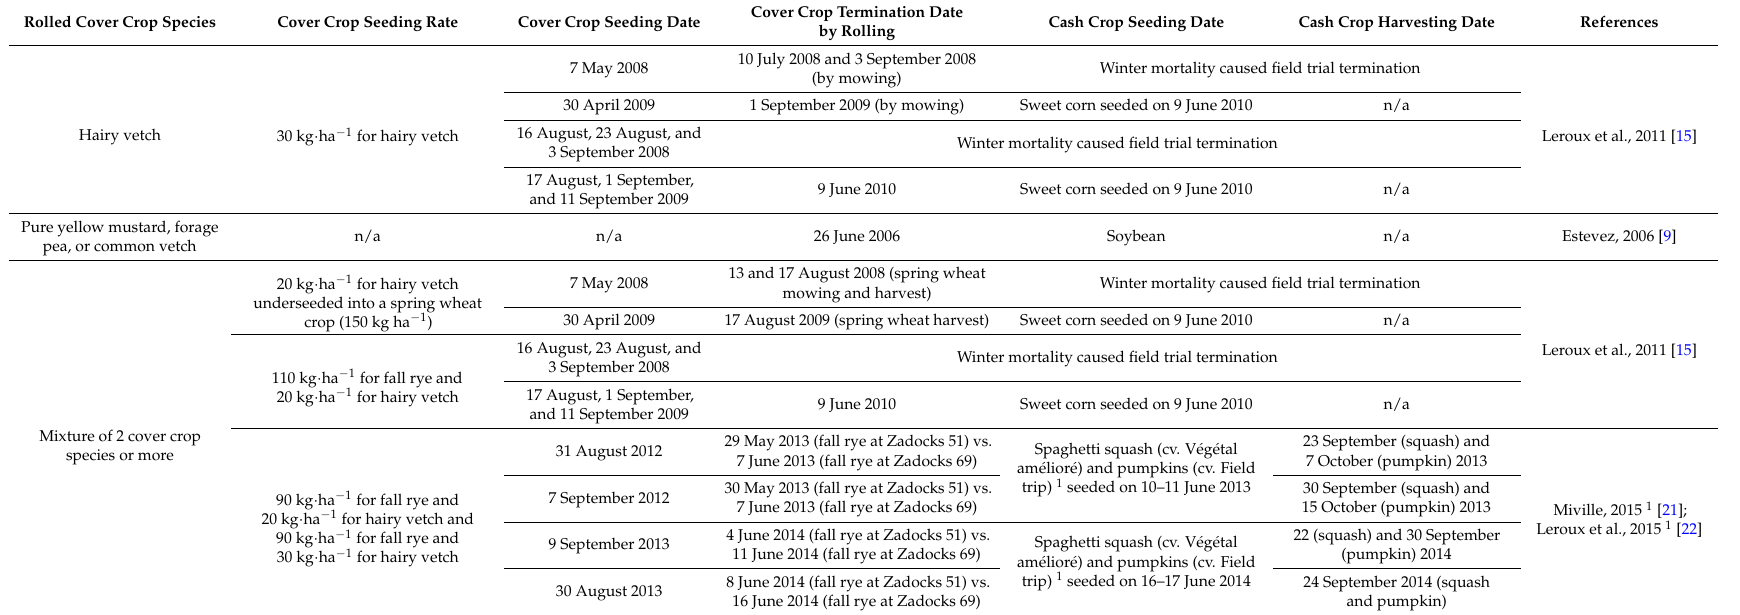
Table 3. Cover crop seeding rate, seeding date, termination date, and cash crop seeding and harvesting dates in organic no-till field trials in Eastern Canada using mulches composed of plant species other than pure fall rye between 2008 and